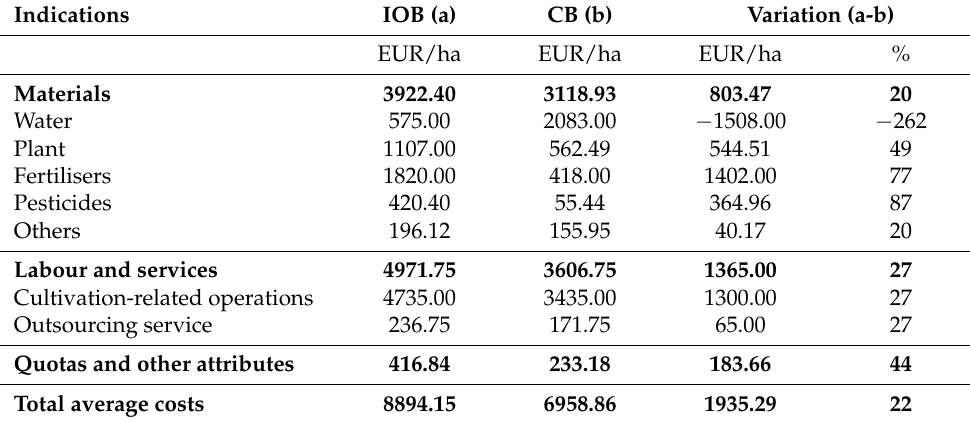
Table 5. Variable costs of broccoli growing